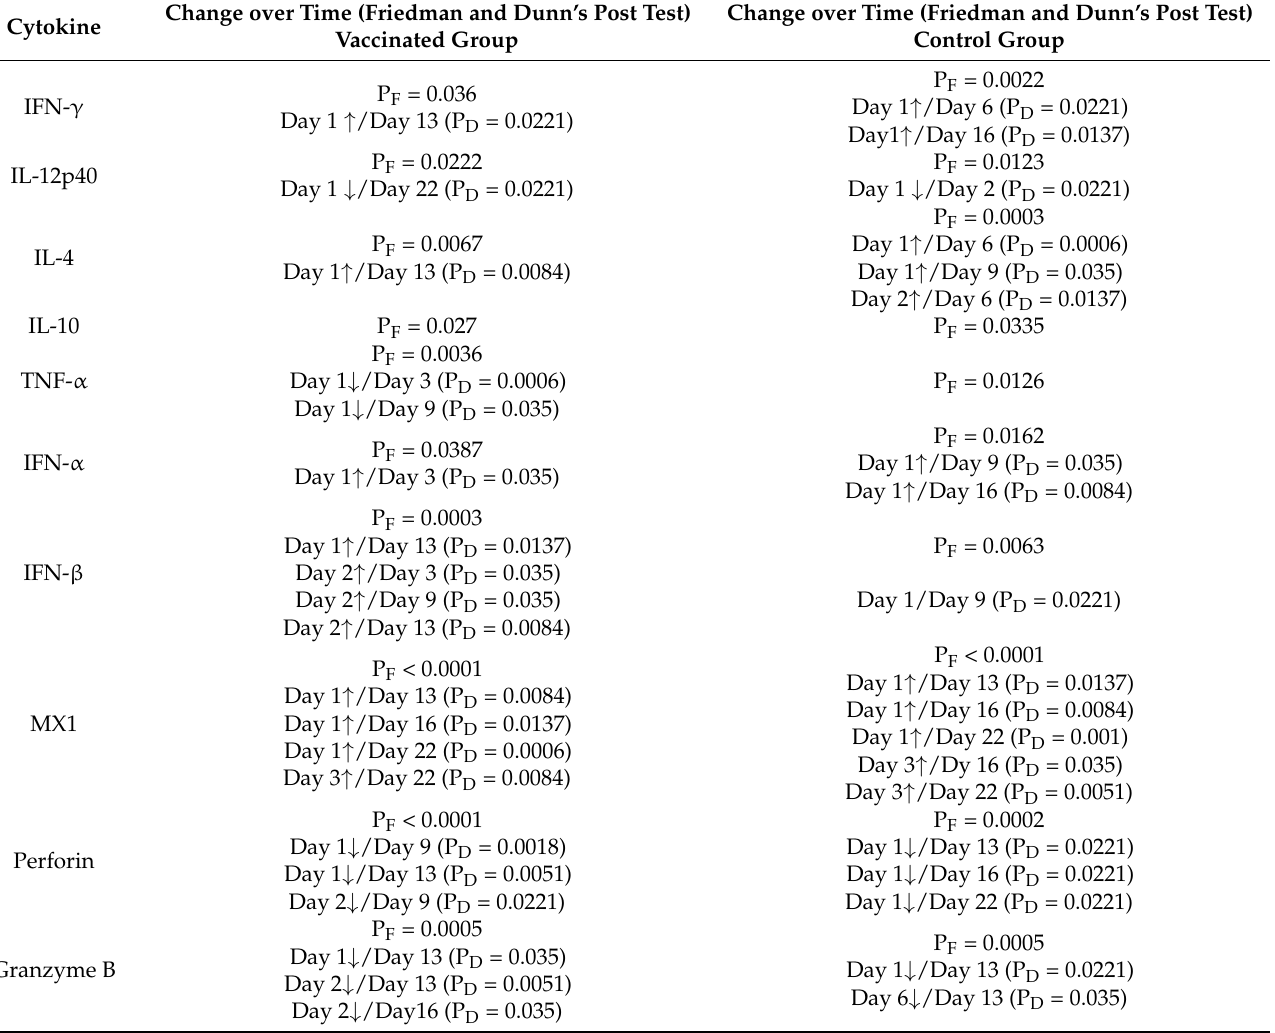
Table A4. Results of Friedman and Dunn’s post test of cytokine mRNA transcription levels after FCV Challenge I. Change over Time (Friedman and Dunn’s Post Test) Cytokine